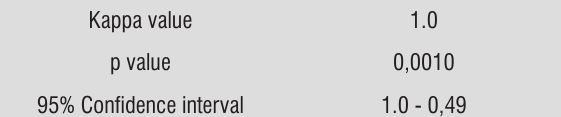
Table 2 - Concordance analysis inter